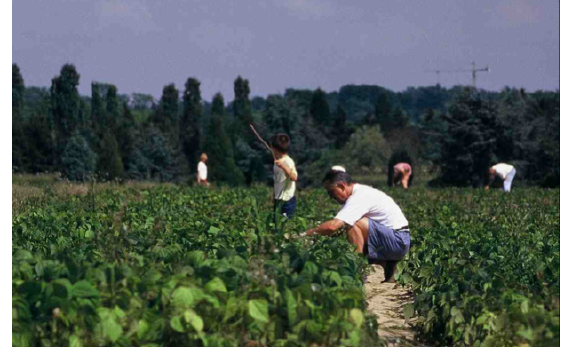
Figure 6. Direct picking, Gally farms, Urban region of Ver- sailles (West Paris).